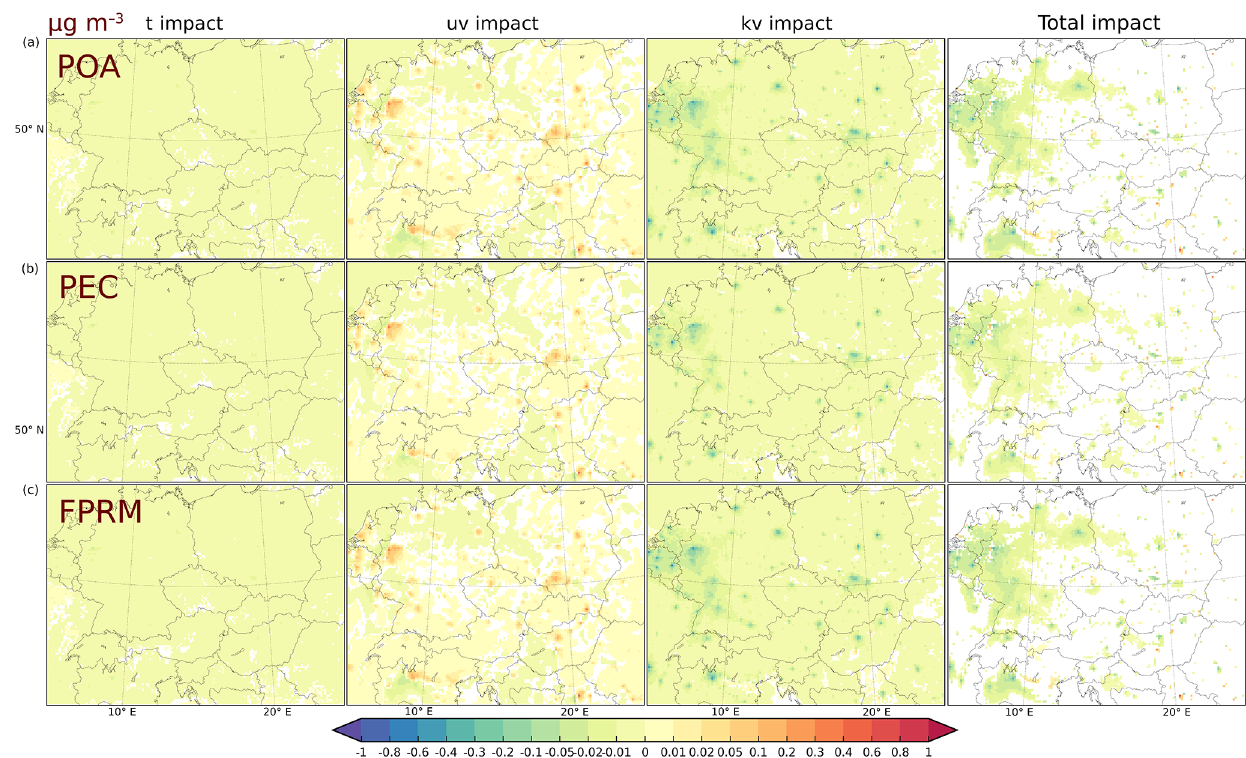
Figure 7. Impact of urban canopy meteorological forcing on (a–c) POA, PEC, FPRM average 2001–2005 JJA surface concentrations in µgm − 3 . The columns from left to right correspond to temperature, wind, turbulence and the total impact. Shaded areas represent a statistically significant impact at the 98% level using the t